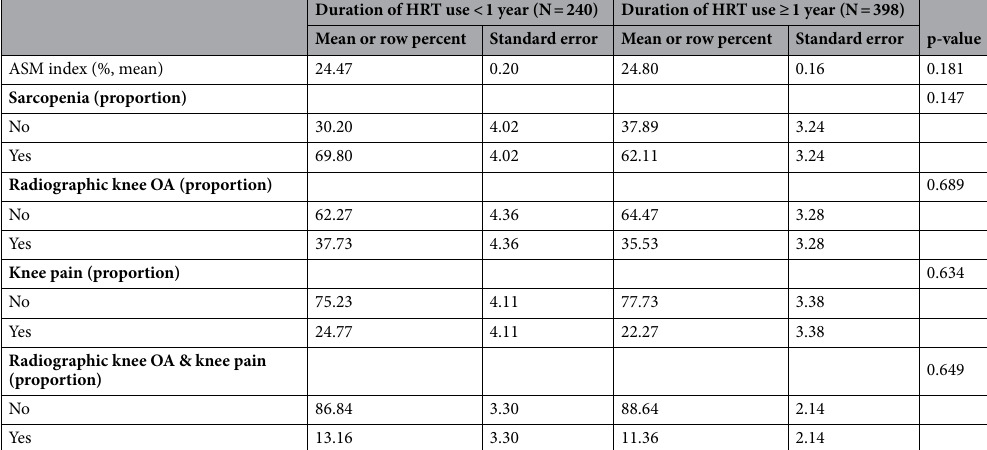
Table 4. ASM index, prevalence of radiographic knee OA, knee pain and both radiographic and knee pain of the women with history of HRT use. Radiographic knee OA, Kellgren–Lawrence grade scale grade ≥ 2; knee pain, knee pain for 30 days over the past 3 months. Continuous variables were analyzed by one-way ANOVA and categorical variables were analyzed by Rao-Scott Chi-square test. OA osteoarthritis, ASM appendicular skeletal muscle mass, Wt body weight, HRT hormone replacement therapy.